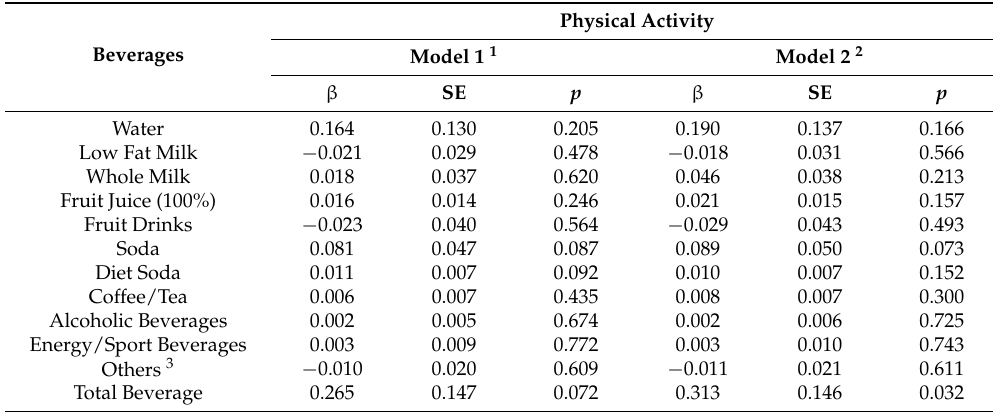
Table 5. Association between physical activity and beverage